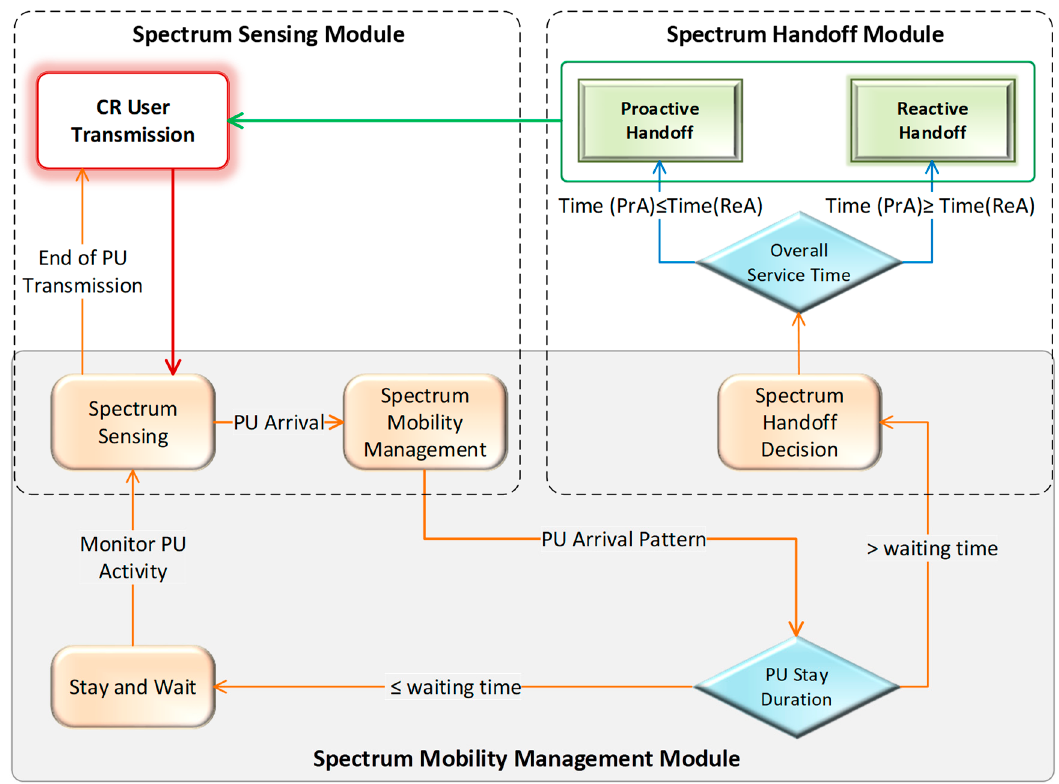
Figure 1. The proposed primary user traffic pattern based opportunistic spectrum handoff framework.